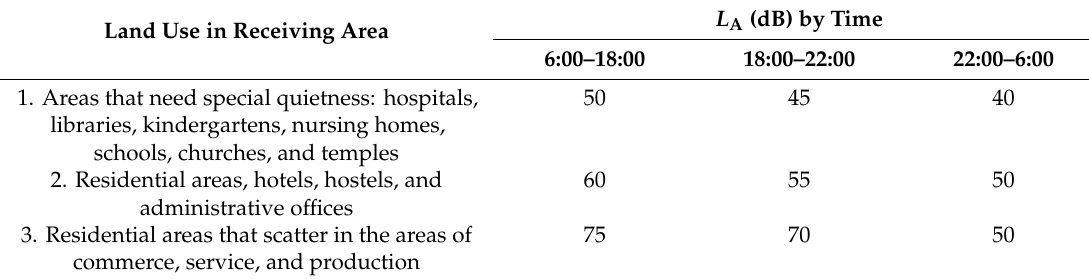
Table 1. Vietnamese National Standard “ TCVN 5949-1998 —Acoustics—Noise in public and residential areas—permitted maximum noise